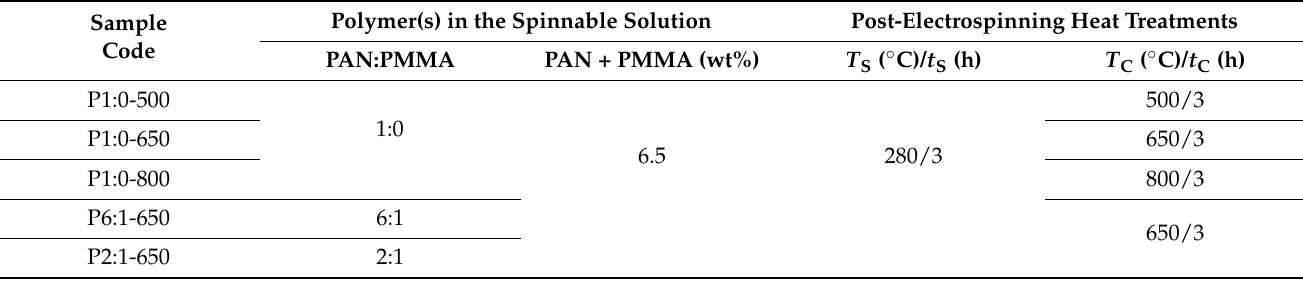
Table 1. Polymer(s) in the spinnable solution and post-electrospinning treatment conditions ( T S and T C denote stabilisation and carbonisation temperatures, respectively; t S and t C indicate the duration of the processes). Temperature increasing rate was 5 ◦ C min − 1 . Both the treatments were followed by uncontrolled cooling down to room temperature (RT). Sample